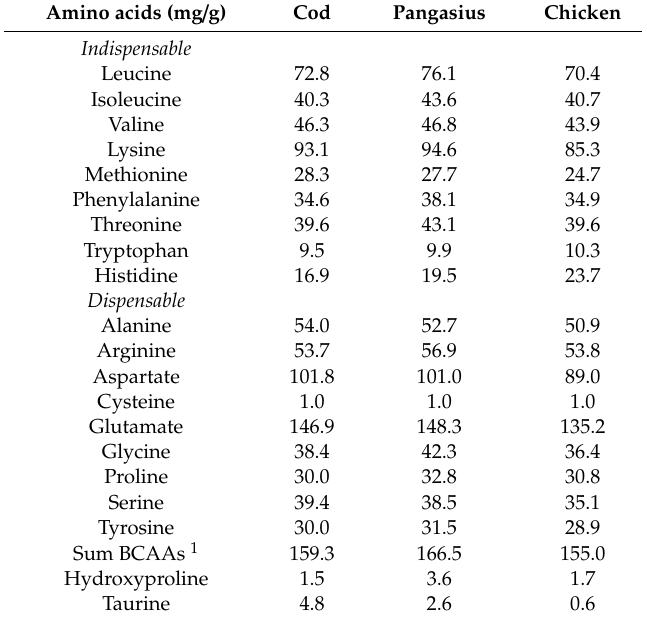
Table 2. Amino acid composition in freeze-dried protein sources used in the experimental diets. Amino acids (mg /